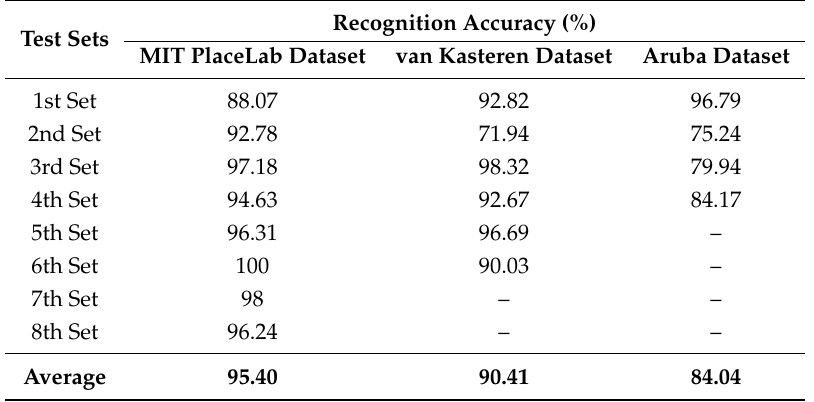
Table 4. Recognition performance in predicting user location based on time for each test set.